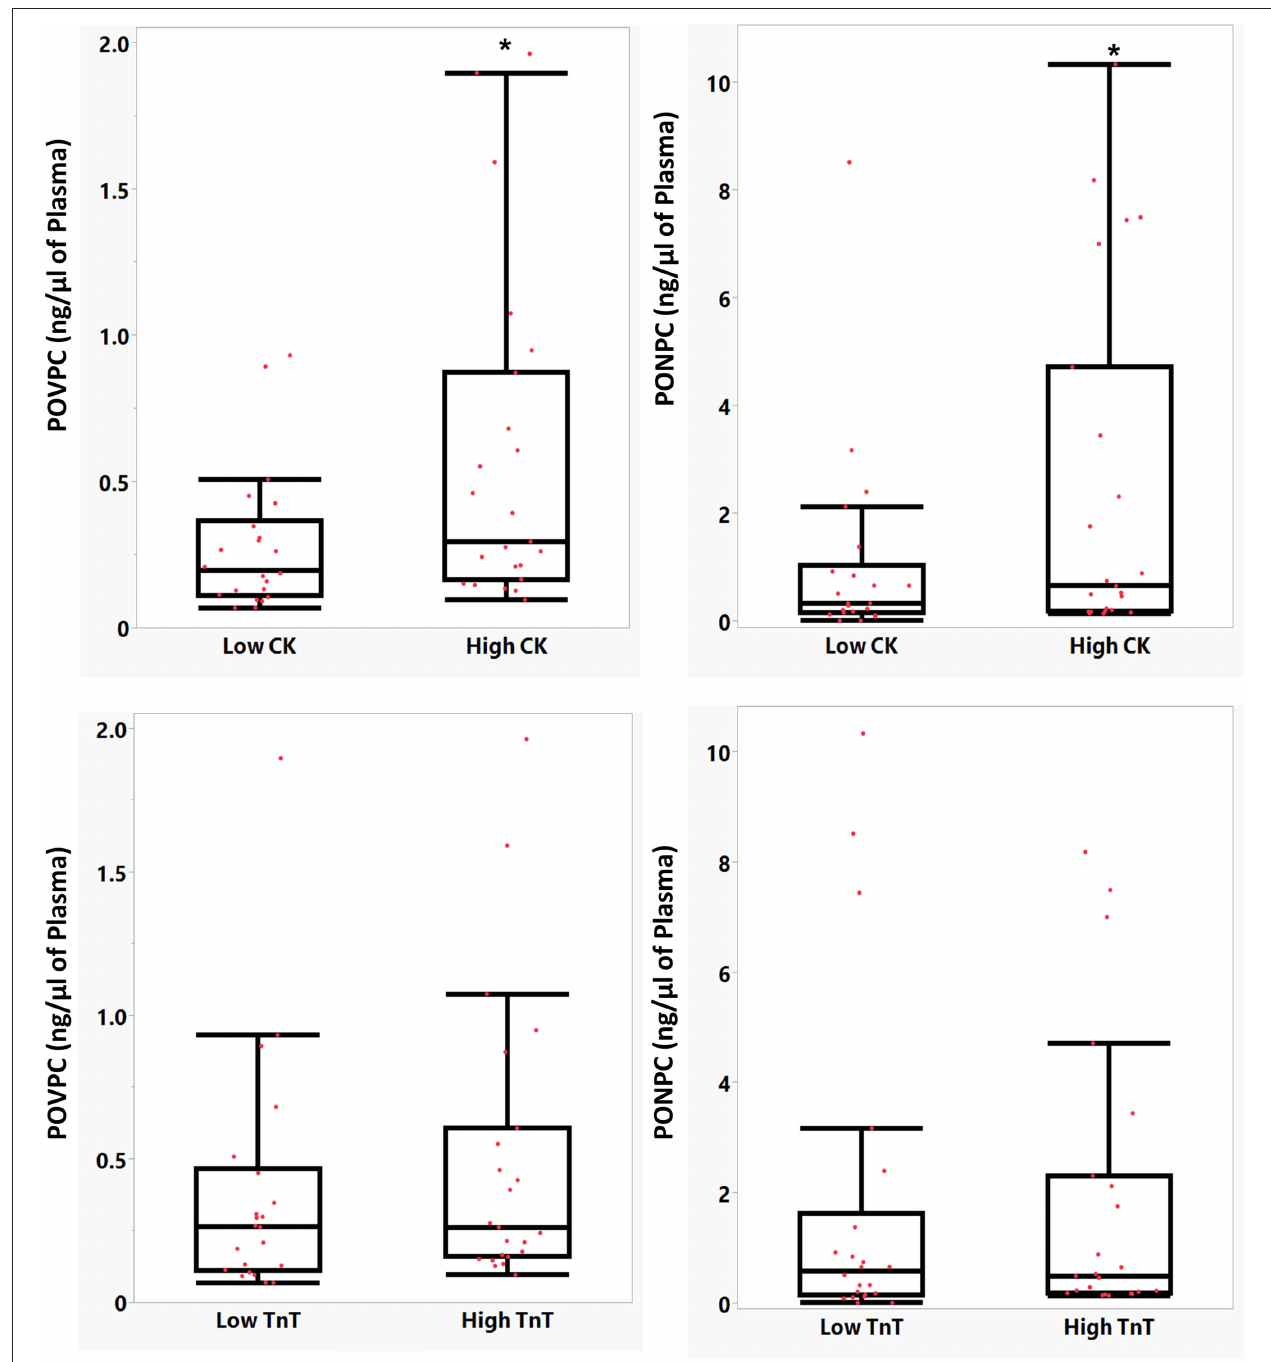
FIGURE 7 | Mean comparison of POVPC and PONPC levels in two groups based on CK (A) and TnT levels (B) . *Statistically significant difference, P < 0.05.